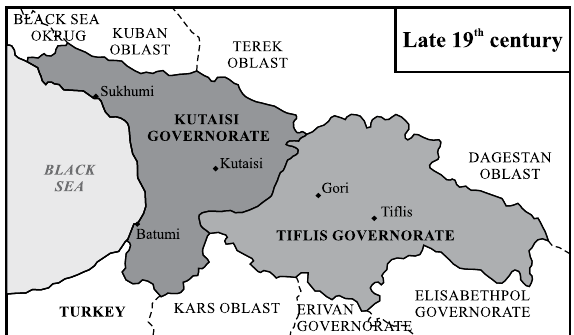
Fig. 4. Stage 4: Unification of Georgian territories. Source: own elaboration based on Furier (2000).